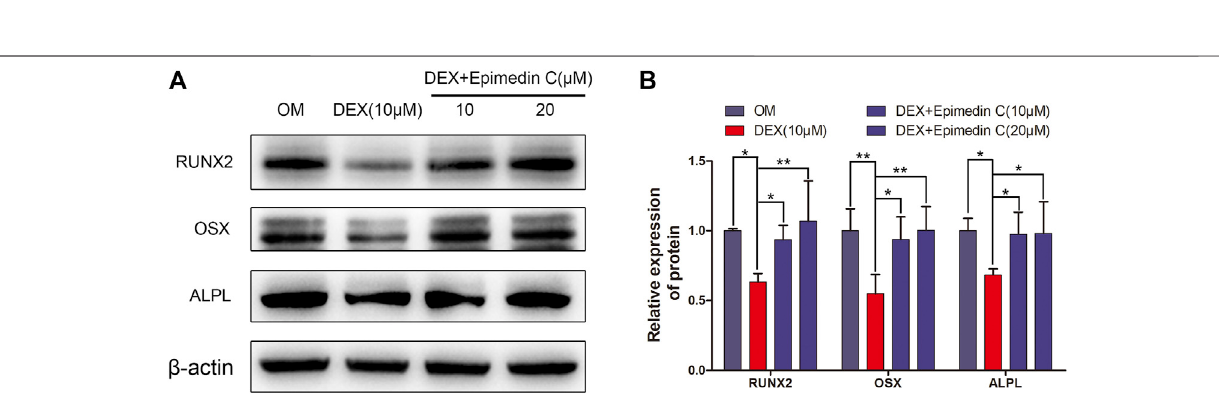
Frontiers in Pharmacology |